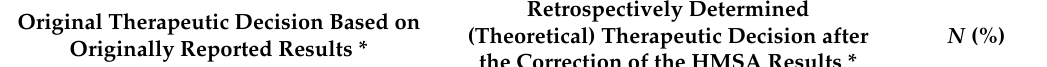
Treatment de-escalation Drug discontinuation Both no change and treatment de-escalation *